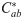
Colorimetric properties of the DHA tanning.(A) Experimental Group. Skin colour distributions in the yellowness vs. redness (b*, a*) and lightness vs. chroma (L*, Cab*) diagrams. Each point represents an individual participant. Different coloured symbols indicate the skin colour at 0h (baseline), 4h, and 24h, respectively. Ellipses represent 95% confidence interval of each distribution. The first and second principal components are shown as solid lines. (B) Example of a skin colour change induced by DHA at 4h (left) and 24h (right) on inner forearm. (C) Control Group. Skin colour distributions of the inner and outer forearm on the (b*, a*) and (L*, Cab*) diagrams. (D) Comparison of the Experimental and the Control Group. Histogram of skin colour differences (CIELAB ΔE) between the baseline (0h) and the DHA tanning (4h and 24h) are compared to the difference between the inner and outer forearm (inn-out) of the control group. Solid curves are Gaussian fits.